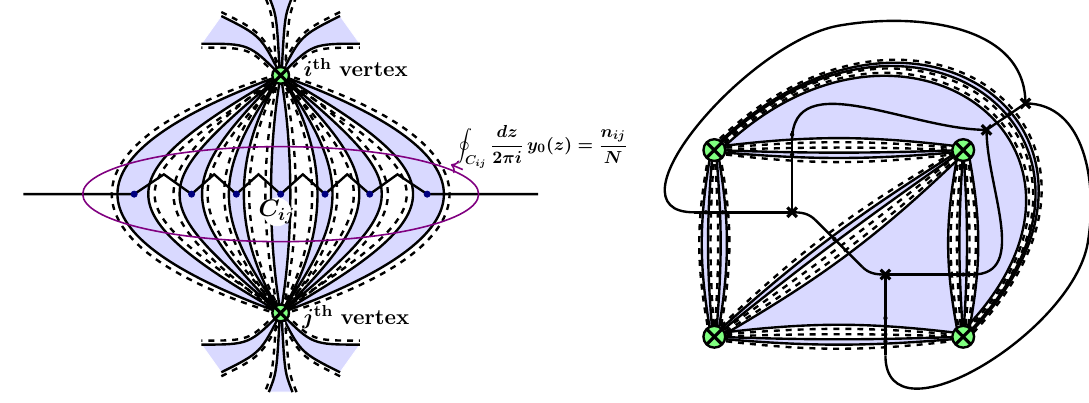
Figure 7 . (Left) The poles of the covering map coalesce to form cuts across the edges of the Feynman graph where the period integral counts the number of Wick contractions. (Right) Feynman graph and it’s dual for the four-point function of each operator with twist two. Figure taken from